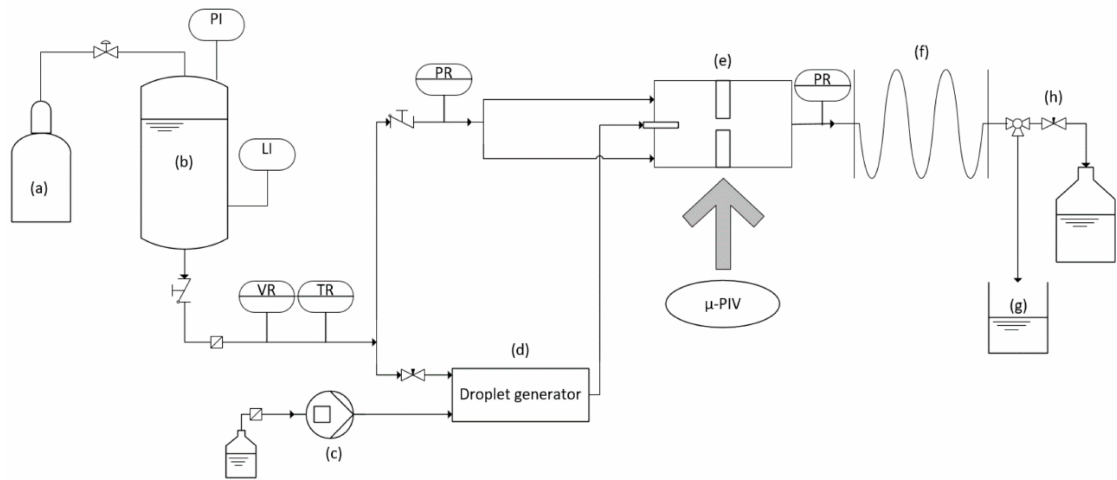
Figure 4. Flow diagram of the experimental setup in enlarged micro scale (M5): nitrogen gas cylinder ( a ), pressure vessel ( b ), displacement pump ( c ), droplet generator ( d ), optically accessible orifice ( e ), sample collecting hose ( f ), sample collecting beaker ( g ) and needle valve ( h